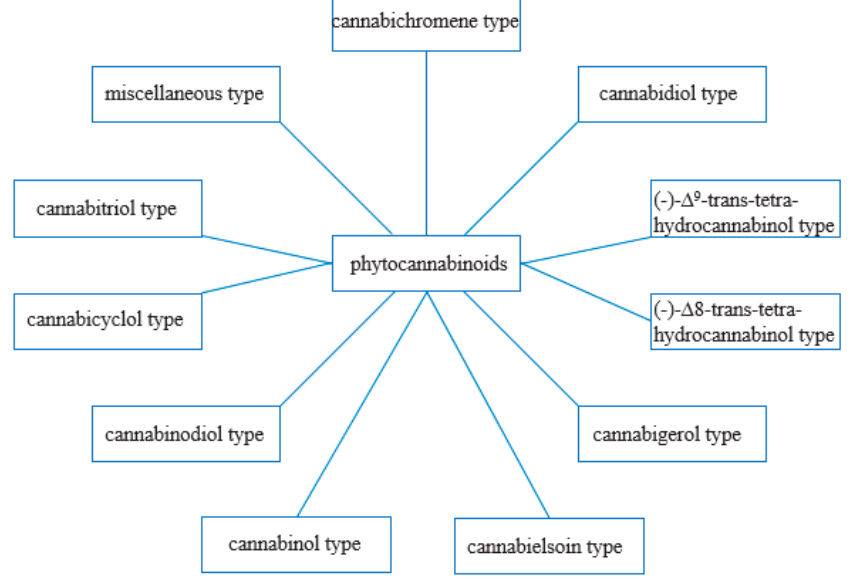
Figure 2. Classes of phytocannabinoids, according to ElSohly M. A. [44].